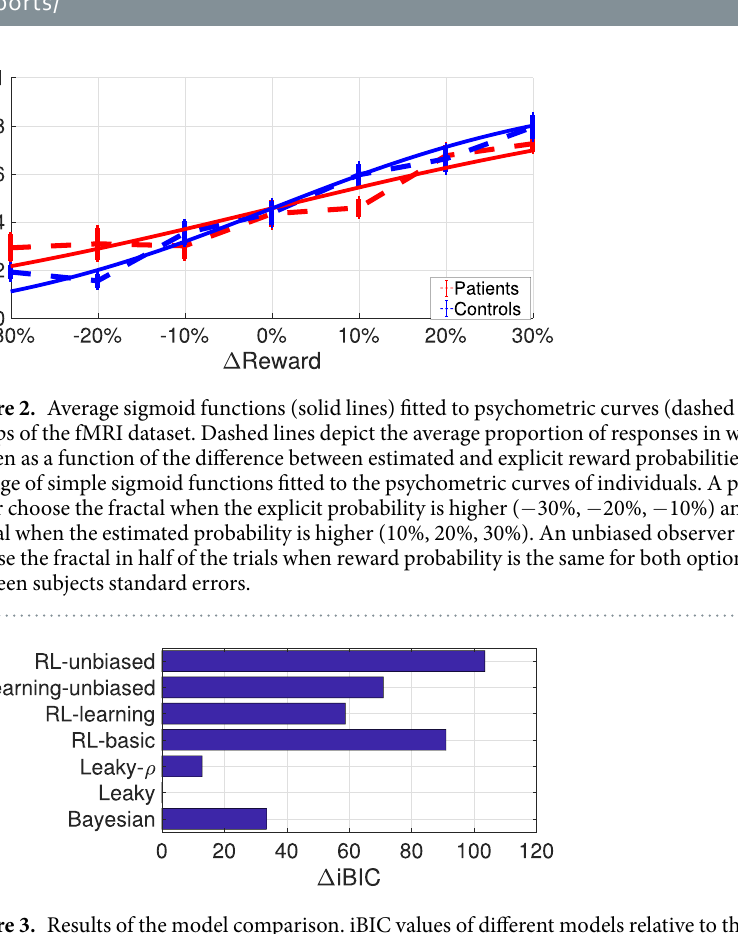
Figure 3. Results of the model comparison. iBIC values of different models relative to the best fitting model Leaky . A difference of 10 or higher is considered strong evidence for the model with the lower value 13